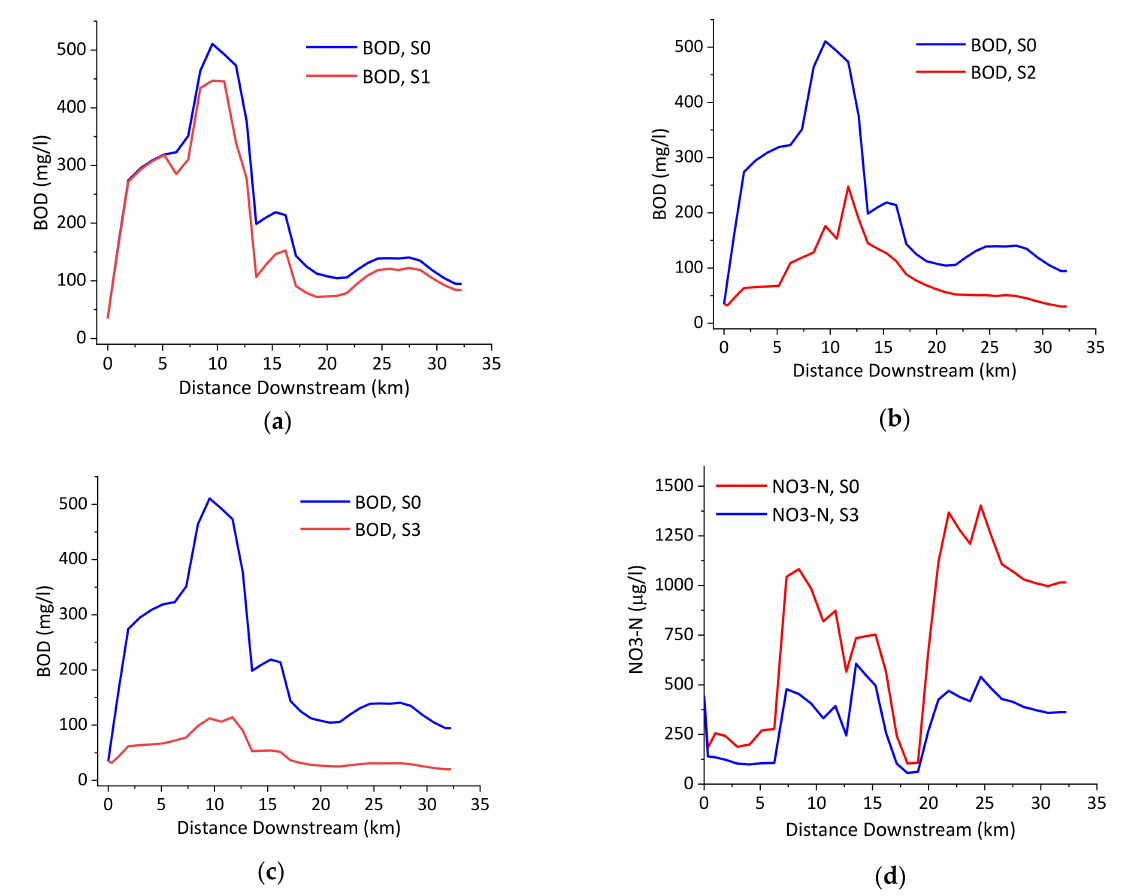
Figure 6. Evaluation of S1, S2 and S3 for BOD ( a – c ) and NO 3 -N ( d ) relative to the base scenario